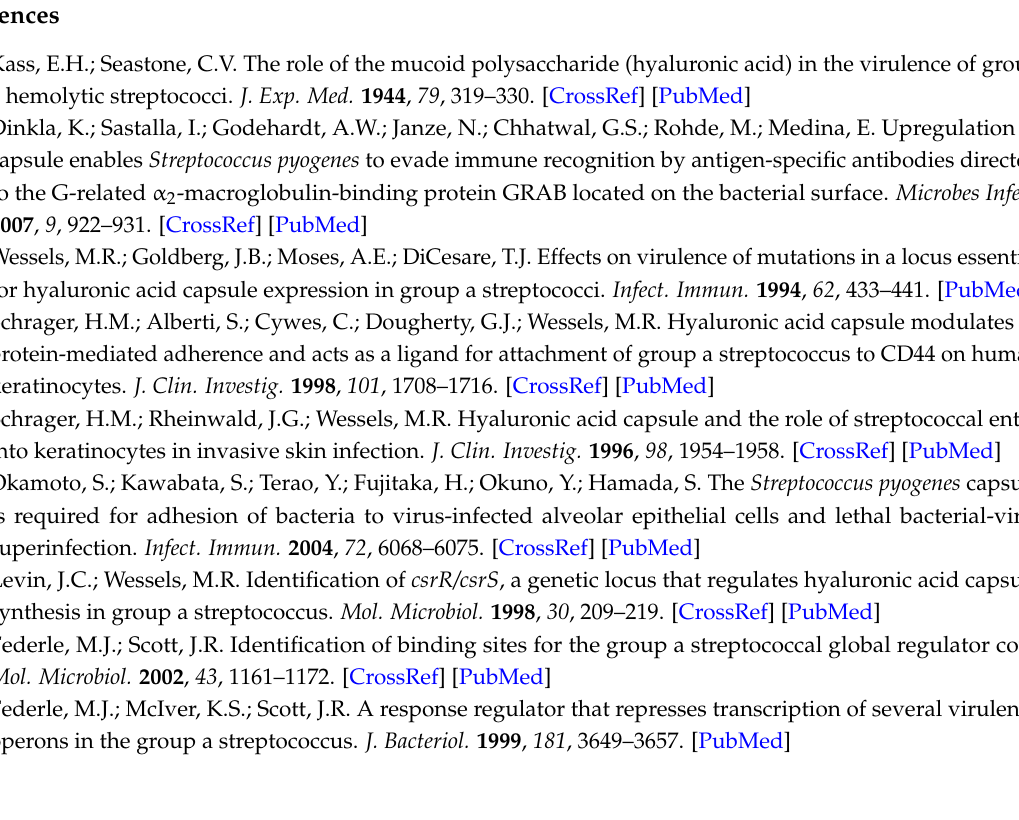
Table S1: Mutation sites in the chromosome of spontaneous capsule thermoregulation